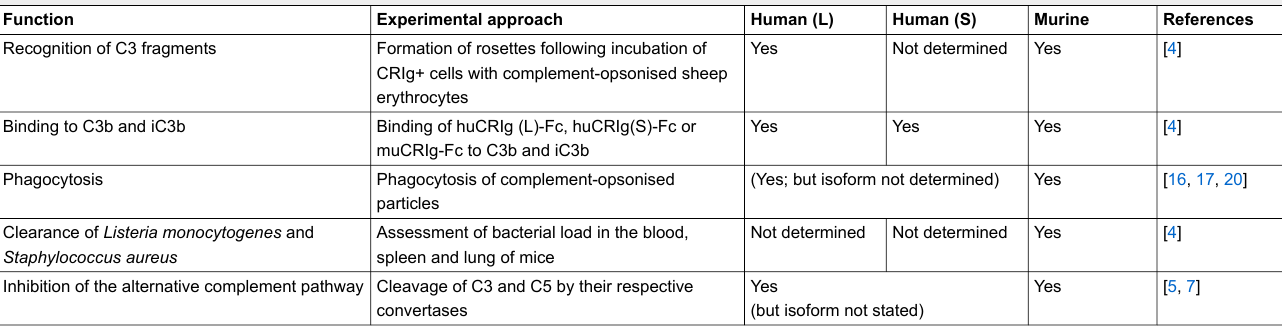
Table 2: Comparison between mouse and human complement receptor immunoglobulin (CRIg) on macrophage phagocytosis.